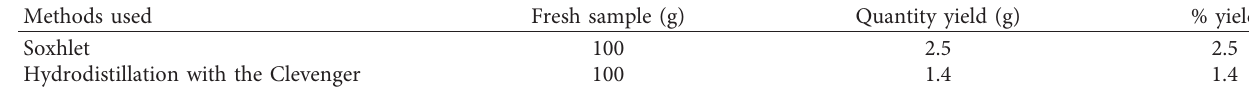
Table 1: Percentage yield of the two methods used.